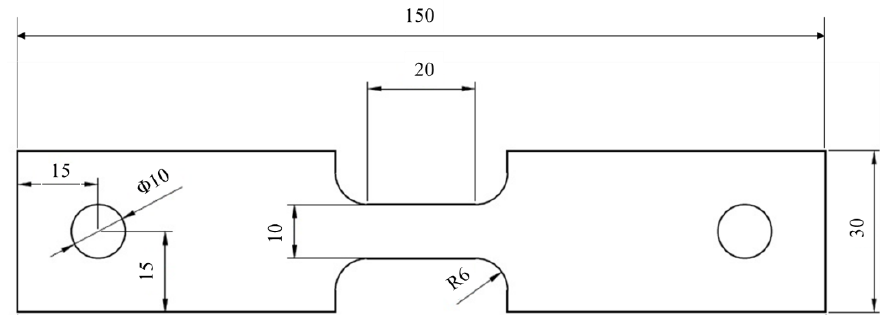
Figure 2. Geometry of specimen in USIBOR ® 2000 for hot tensile test with Gleeble system.